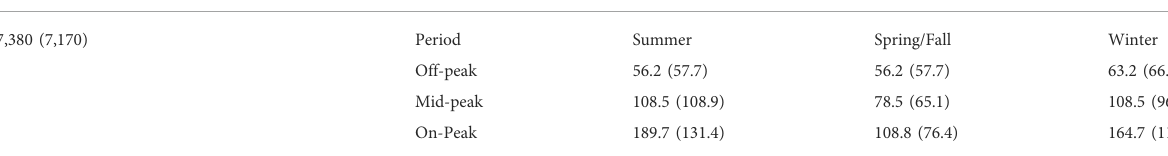
TABLE 2 Electricity rate